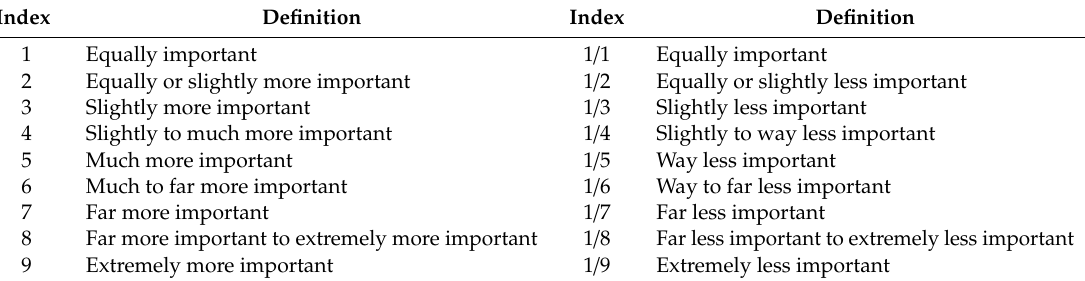
Table 5. Saaty scale for pairwise comparison between the criteria in the AHP.